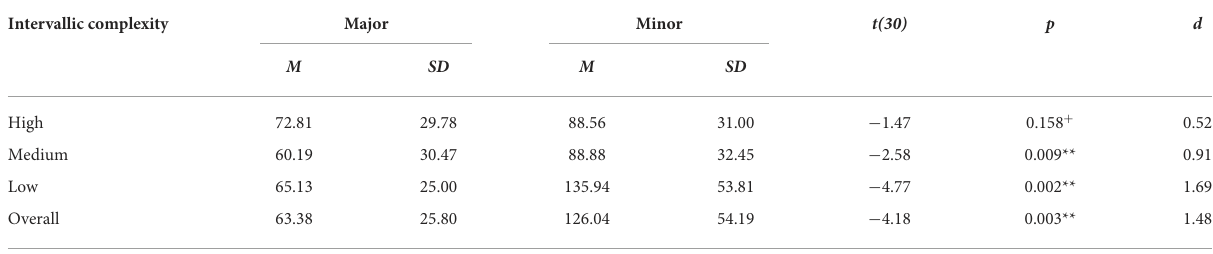
TABLE 2 Means and standard deviations of three dependent variables for an efficiency of input, as well as results of bootstrap t -tests with Bonferroni’s correction ( subset α = 0.025) for effects of modality on each measure. Number of